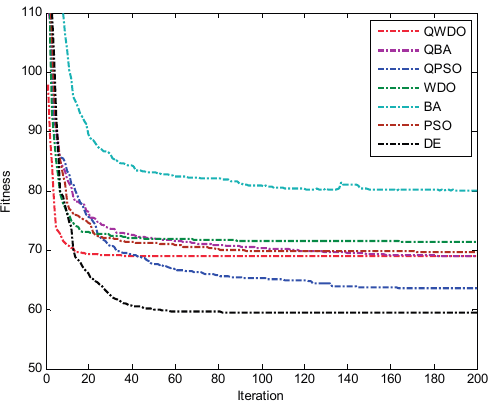
Figure 8. Fitness of the first instance for D =